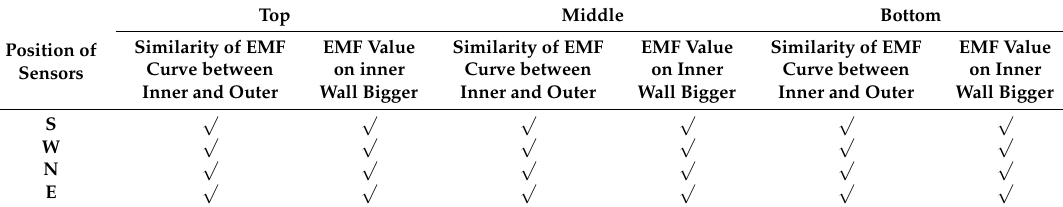
√ : Similar to the Figure 8